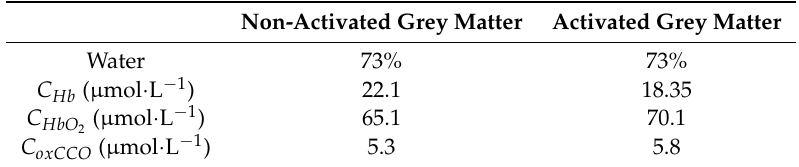
Table 2. Chemical composition of the chromophores of the simulated volumes of grey